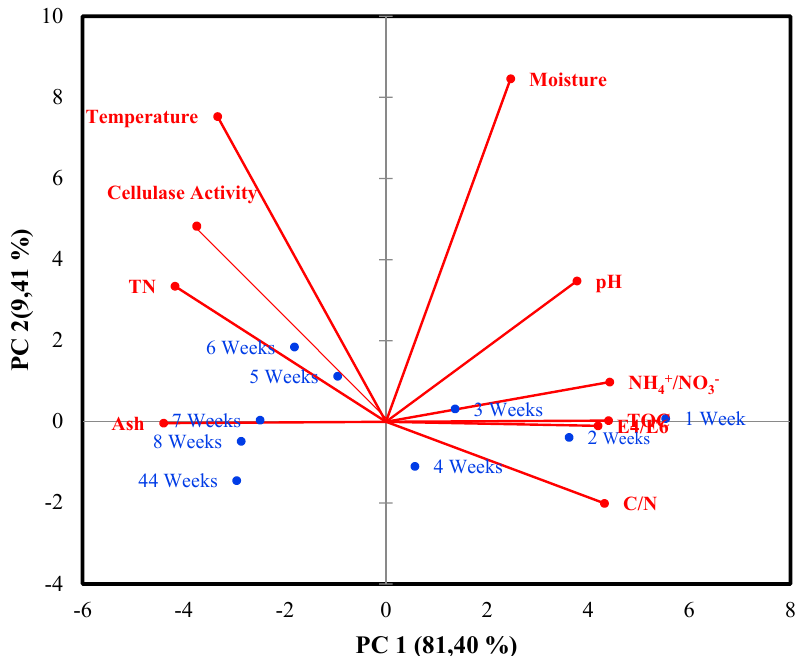
Figure 4. Results of PCA analysis. Each circle is the barycentre co-ordinate with standard deviation of each stage of composting. TOC: total organic carbon; TN: total nitrogen; C/N: carbon/nitrogen ratio; NH 4+ /NO 3 − ratio: ammonium nitrogen /nitrate nitrogen; Q 4 /Q 6 ratio: 472/664 nm.